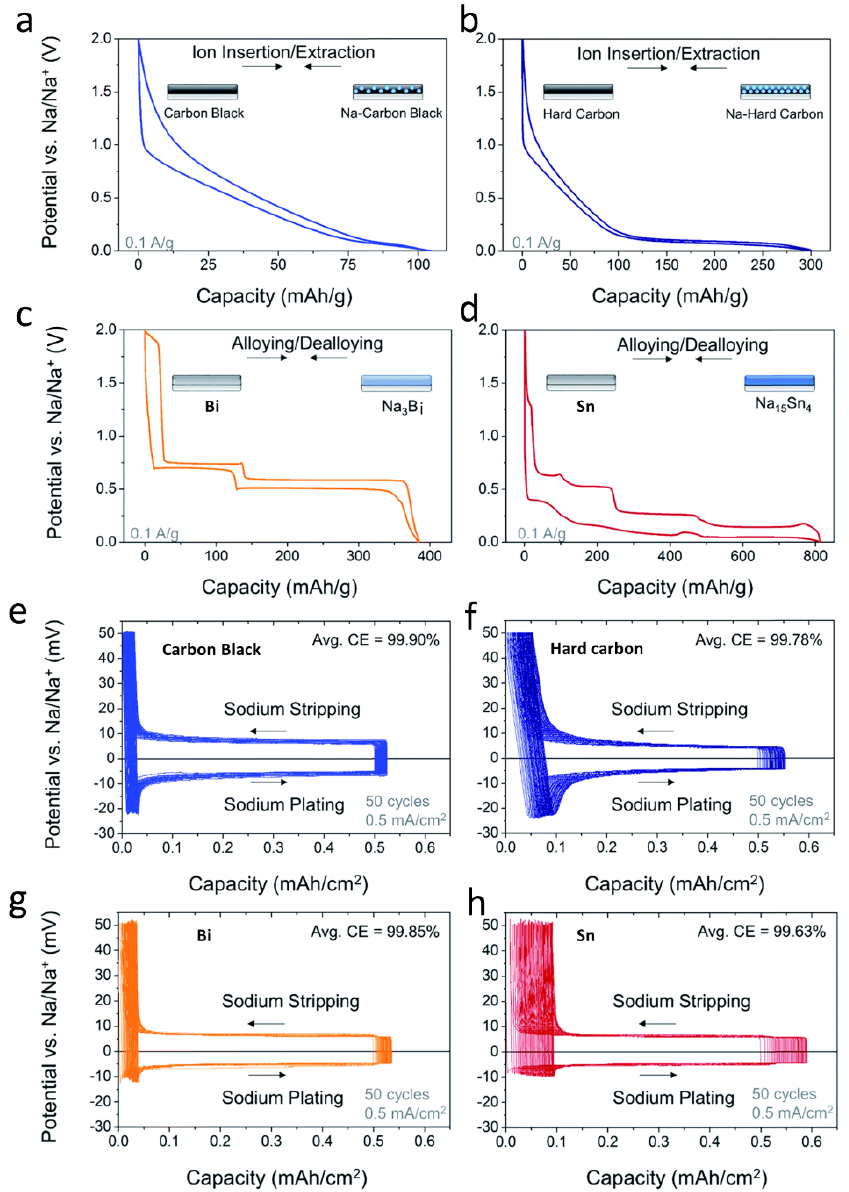
Figure 5. Electrochemical charge/discharge profiles of the ( a ) carbon black, ( b ) hard carbon, ( c ) bis- muth (Bi), and ( d ) tin (Sn) electrodes with a current rate of 0.1 A g − 1 . Slippage profiles of the Na plating/stripping on the four different nucleation layers over 50 cycles at a current density of 0.5 mA cm − 2 : ( e ) carbon black, ( f ) hard carbon, ( g ) Bi, ( h ) Sn [63]. Reproduced with the permission of ref. [63] Royal Society of Chemistry, copyright 2018.